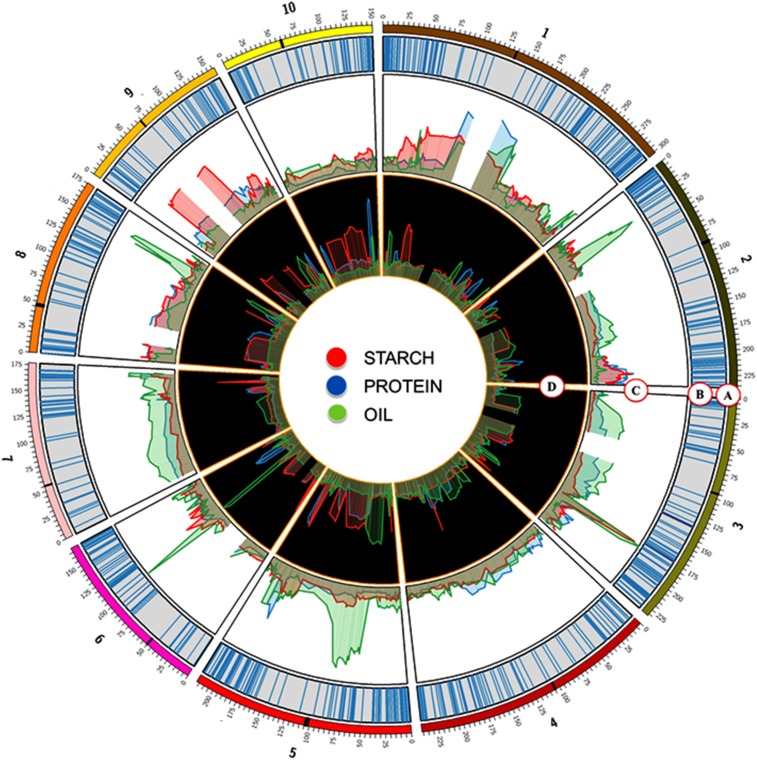
Circos plot displaying: (A) the 10 chromosomes of maize, (B) physical coordinates of the SNP markers, (C) joint-linkage QTL peaks in the teosinte NIL analysis, and (D) joint-linkage QTL peaks in the NAM analysis (Cook et al. 2012).